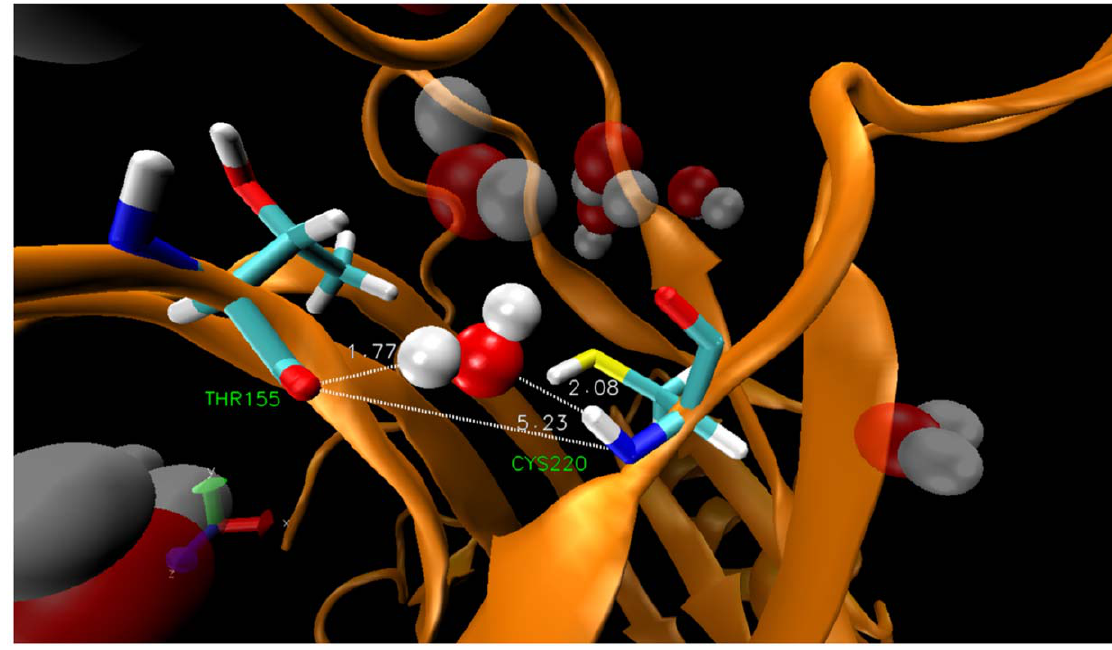
Figure 5. An instance of intercalation of a water molecule between THR 155 and CYS 220 in 2J1X.